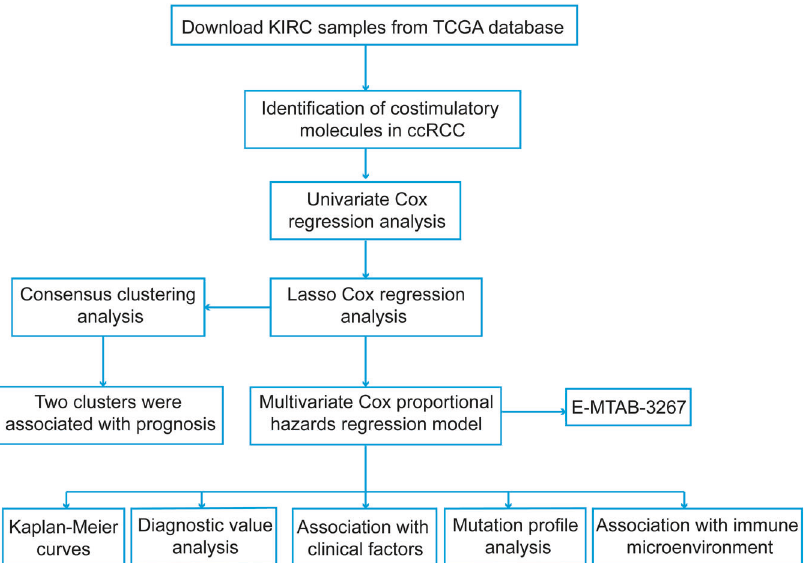
Fig. 1 The fl owchart of the present study design. The mRNA expression data of tumor and normal tissues were downloaded from TCGA database and ArrayExpress database (E-MTAB-3267). Survival-related costimulatory molecules were obtained and the associations with tumor immune microenvironment were